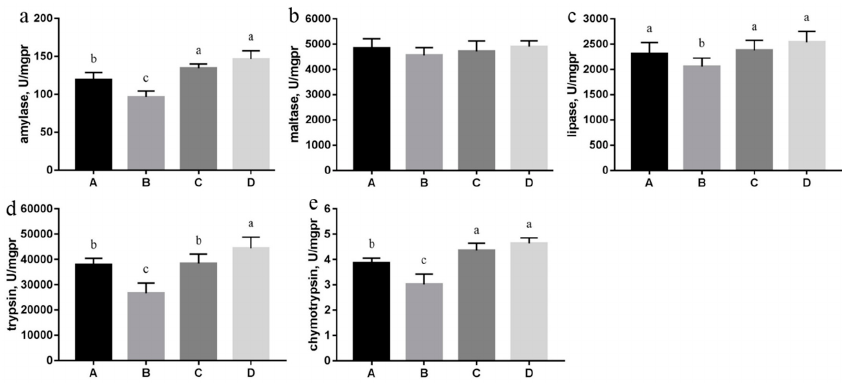
Figure 2. Effect of betaine on digestive enzyme activities of high-salt stressed Sprague–Dawley rats ( n = 8 in each group). Note: a,b,c Values without common letters above the histogram differ significantly ( p < 0.05). A: control group with standard diet (0.4% NaCl); B: high-salt diet (4.0% NaCl); C: high-salt diet (4.0% NaCl) with 0.5% betaine; D: high-salt diet (4.0% NaCl) with 1.0% betaine; ( a ) amylase; ( b ) maltase; ( c ) lipase; ( d ) trypsin; ( e ) chymotrypsin.